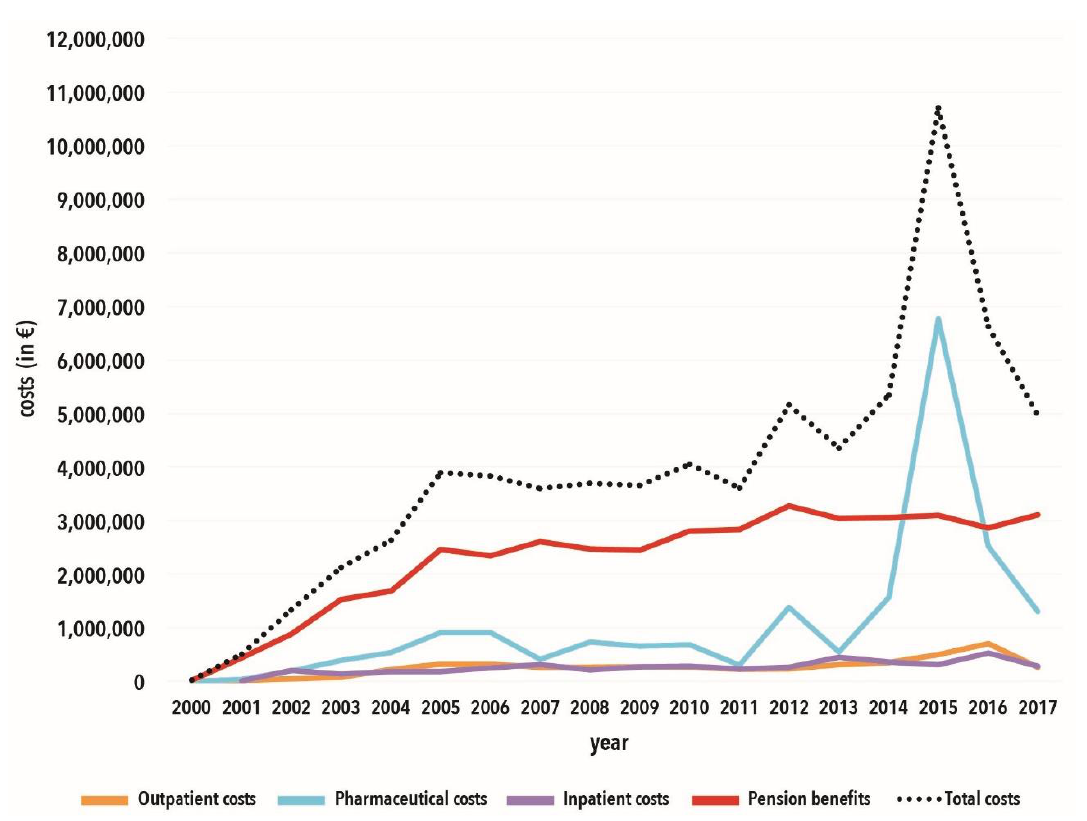
Figure 2. Cost trends of medical services and pension benefits of the Institution for Statutory Accident Insurance and Prevention in the Health and Welfare Services (BGW).